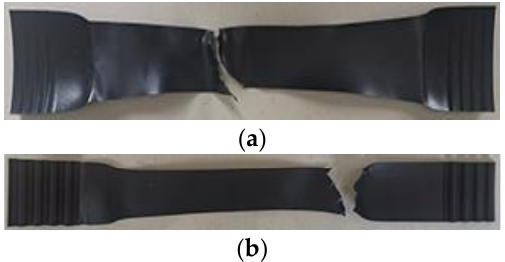
Figure 6. Fracture modes of the HDPE specimens. ( a ) Type I; ( b ) Type II.